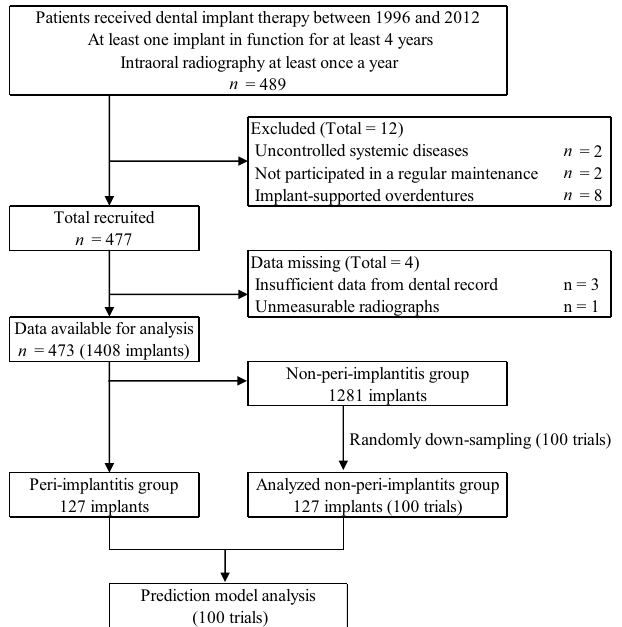
Figure 1. Flow diagram outlining the inclusion and exclusion criteria and study design. This figure was created with Excel 2019 version 1808 (Microsoft, Inc, Redmond,